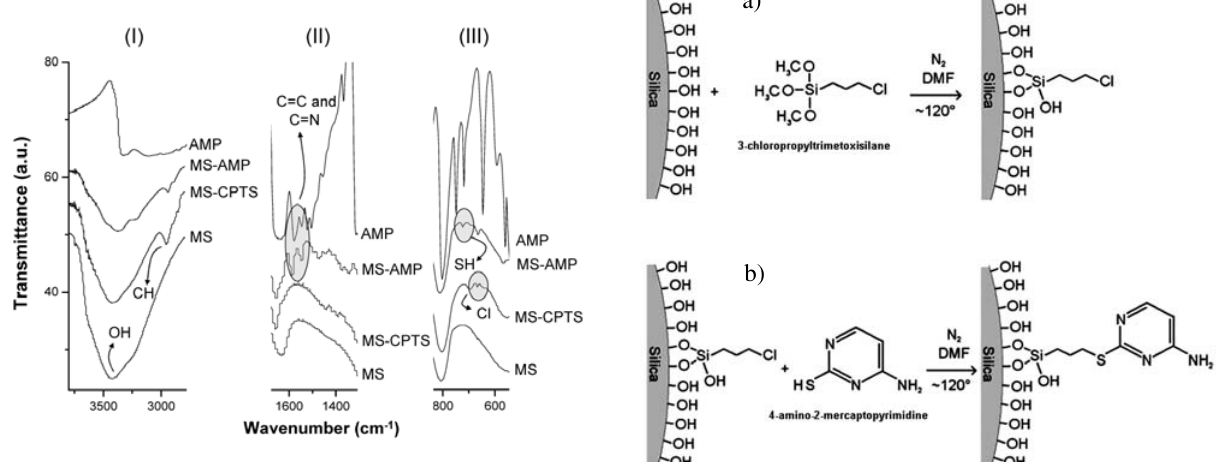
Figure 3. Infrared spectra of the nonfunctionalized mesoporous si- lica ( MS ), the silanized mesoporous silica ( MS-CPTS ), the mesopo- rous silica modified with the ligand ( MS-AMP ), and the ligand ( AMP ). The spectra are divided in three ranges to better observe the vibrational bands.